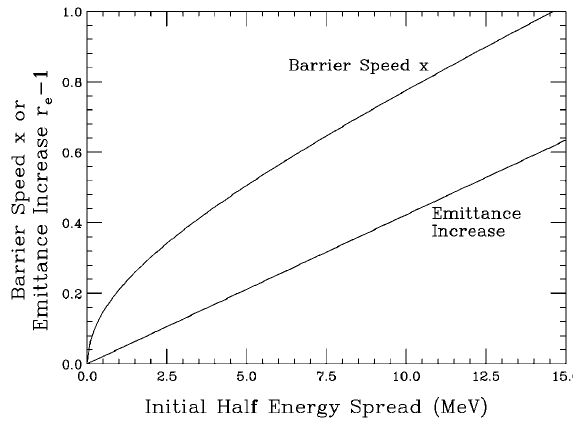
FIG. 5. The slowest or critical speed of the moving barrier and the longitudinal emittance increase versus the half energy spread of the booster